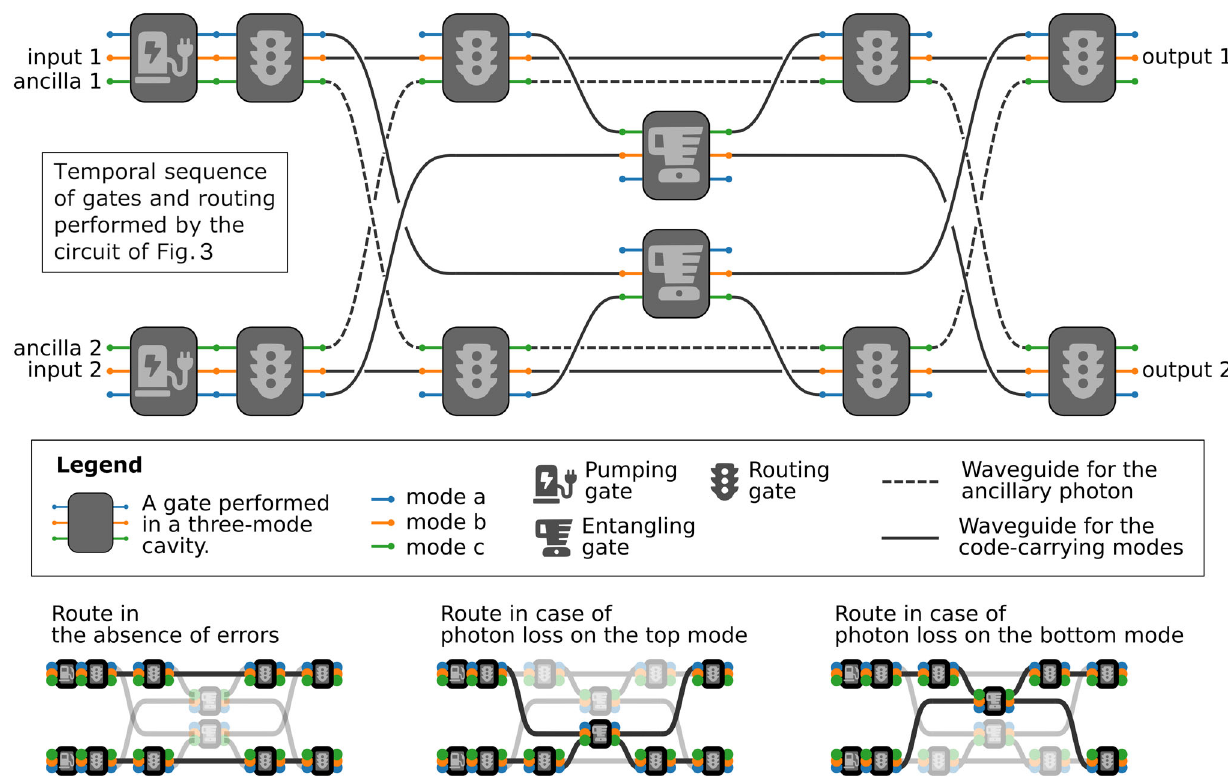
Fig. 4 The error-correcting circuit, unrolled in time. The horizontal axis represents the fl ow of time, depicting how a pair of triply-resonant cavities is being used. This circuit would be executed on the hardware depicted in Fig. 3. The main drawing is the sequence of operations that we need to perform in parallel in the two triply-resonant cavities, in order to perform the error correction. After placing the code and ancilla modes in the appropriate cavity modes, we accomplish the initial pumping and routing gates. After that, we need to shuf fl e the ancillary modes by releasing them in the appropriate waveguides. The spatial modes into which the code states are moved depend on the state of the ancillas, thanks to the conditional routing gates. As the ancillas contain information about the presence of photon-loss errors, this lets us perform operations conditioned on the loss of a photon, by performing the two conditional branches in parallel in different physical locations of the circuit. The conditional routing gates then act in reverse, ensuring that all spatial modes end in the same location, without breaking the bijectivity required for any quantum circuit. The various spatial modes employed can be seen in the bottom insets of the fi gure. Supplementary Figure 1 provides a more detailed rendition. Importantly, as seen in Fig. 3, we do not need 12 triply-resonant cavities as depicted above, rather only 2 cavities with a network of waveguides and programmable beam splitters 72 that can route the spatial modes as necessary, so that each cavity can be used repeatedly. The gate pictographs are taken from the Font Awesome icon